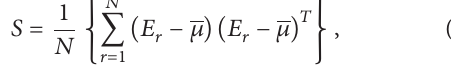
wave and it is started from FP + 150 ms to FP + 420 ms. Ten amplitude features are derived from this window. In all three windows the features are derived using linear interpolation method where the signal is sampled